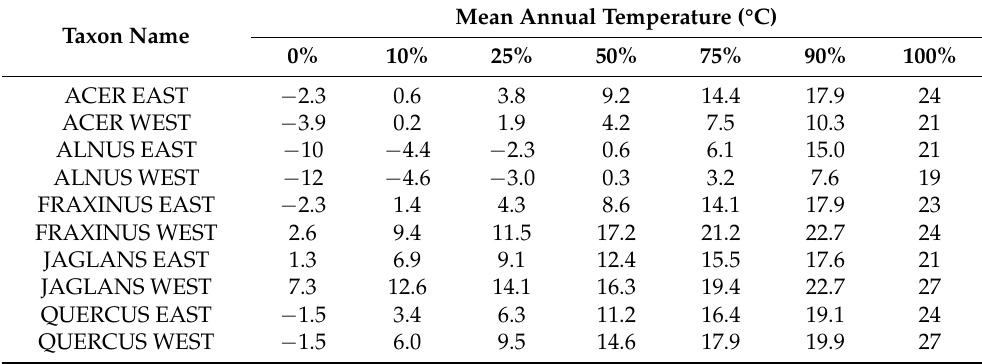
Table 9. A part of the hardwood data using quantile representation.